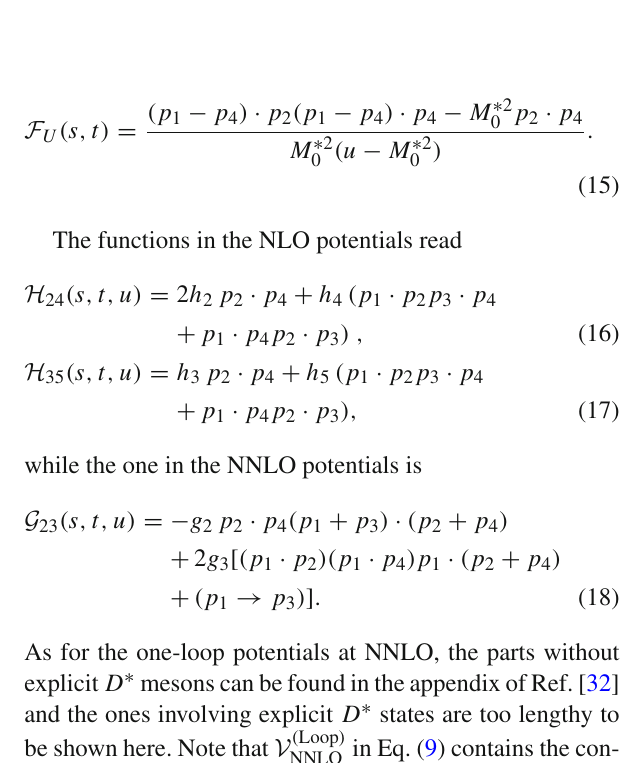
Fig. 1 Feynman diagrams contributing to D φ scattering up to NNLO with explicit D ∗ mesons. The dashed, solid and double-solid lines stand for Goldstone bosons φ , pseudo-scalar D mesons and vector D ∗